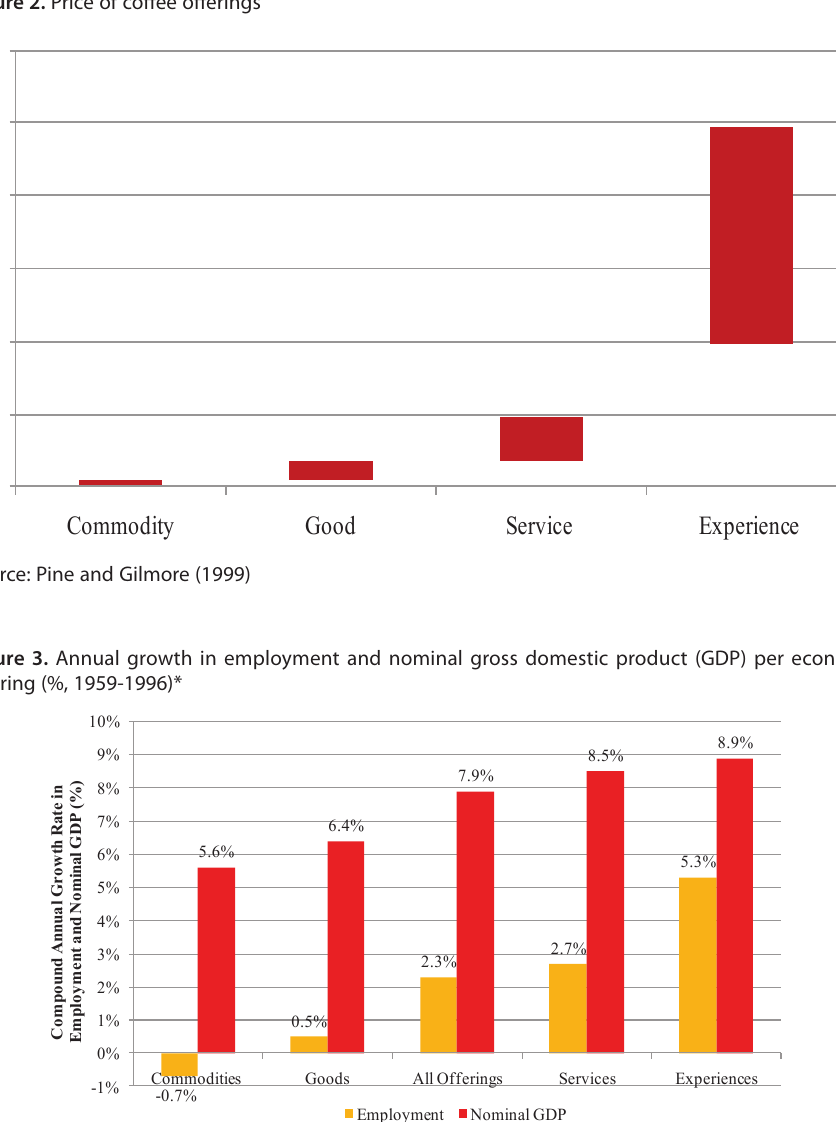
Figure 2. Price of coffee offerings